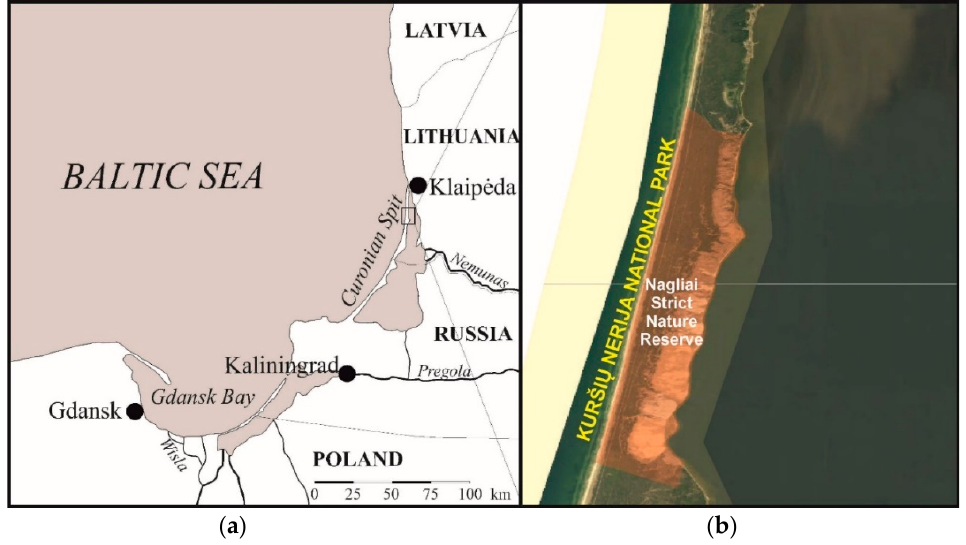
Figure 8. The target territory of the GIS background and output maps: ( a ) The location of the target territory in the Southeast Baltic Area; ( b ) Nagliai Strict Nature Reserve within the Kuršiu˛ nerija national park. The target area is shadowed in reddish (Drawn by Arvydas